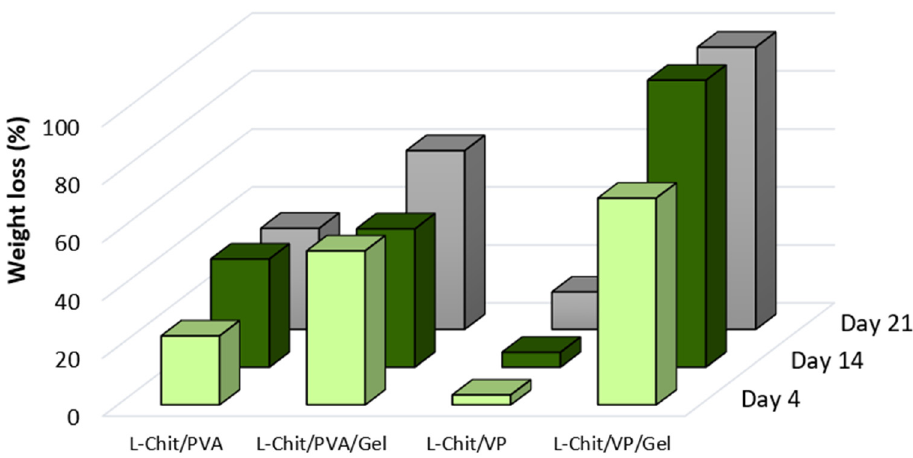
Figure 6. Weight loss of low-Mw chitosan-based membranes γ -irradiated at 10 kGy after 4, 14 and 21 days immersed in saline solution at 36 °C.